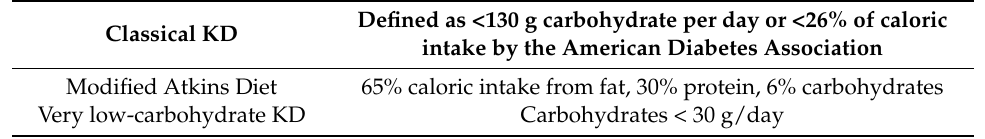
Table 1. Standard composition of ketogenic diets in adults * (calculated for a 2000 kcal diet/day). Classical